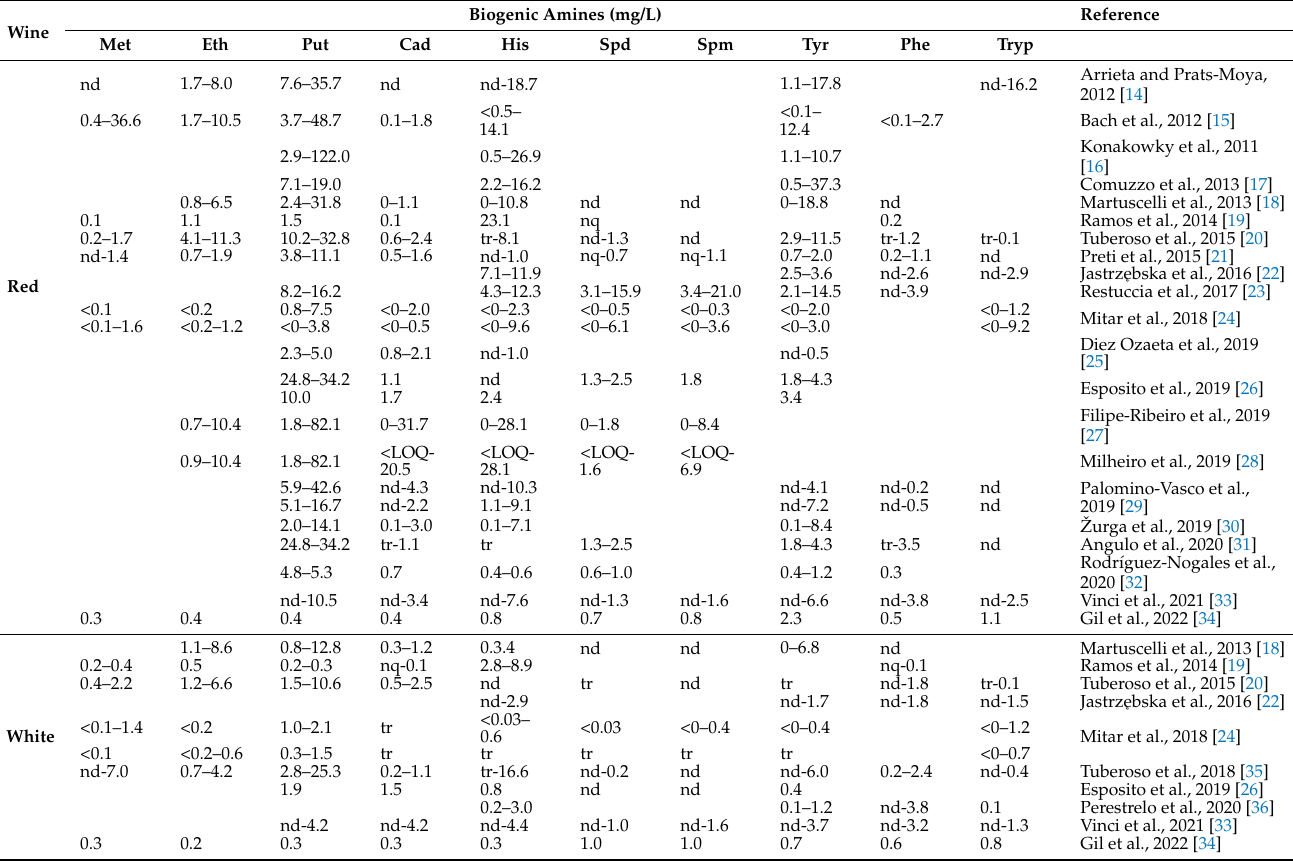
Table 2. Biogenic amines amount (min–max levels) in red and white